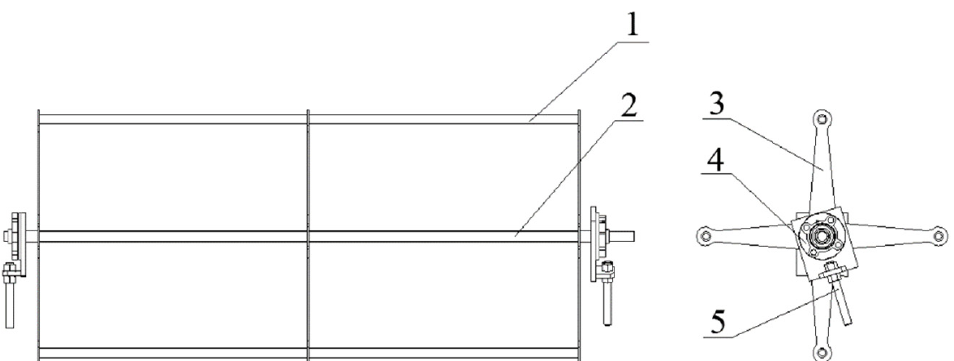
Figure 3. Structure diagram of dial wheel device. Note: 1. rod; 2. shaft; 3. plate; 4. bearing; 5. installation of height adjusting mechanism.